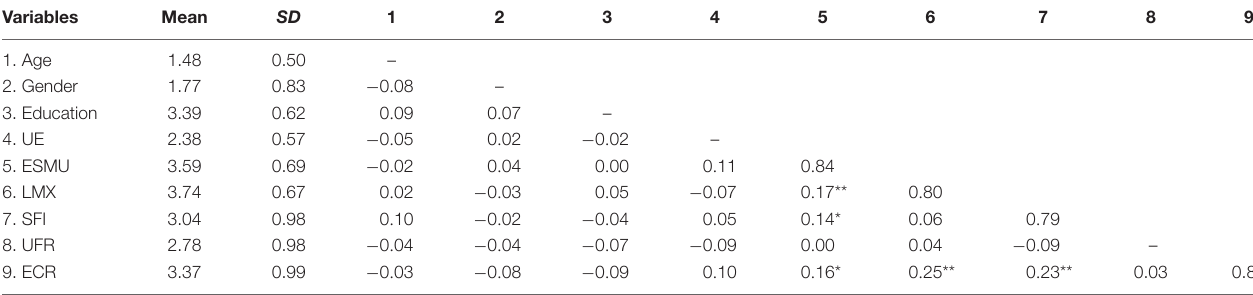
TABLE 1 | Correlation matrix.